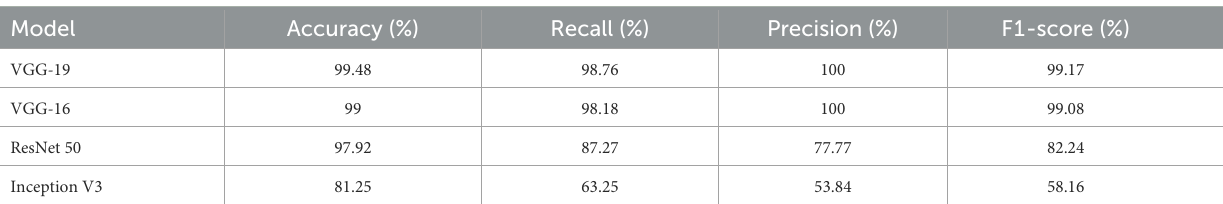
TABLE 2 Performance metrics of classification